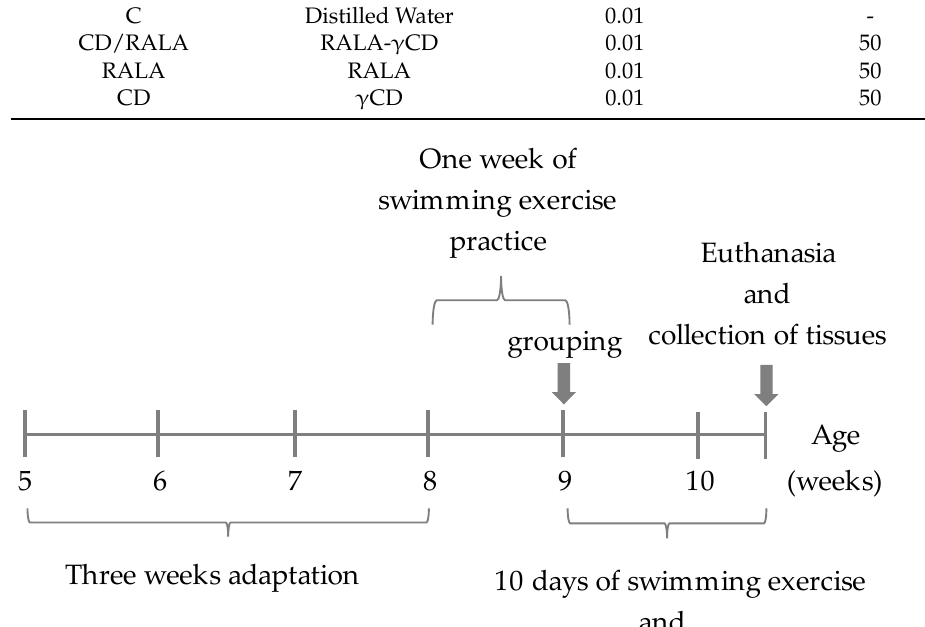
Figure 3. Experimental protocol.